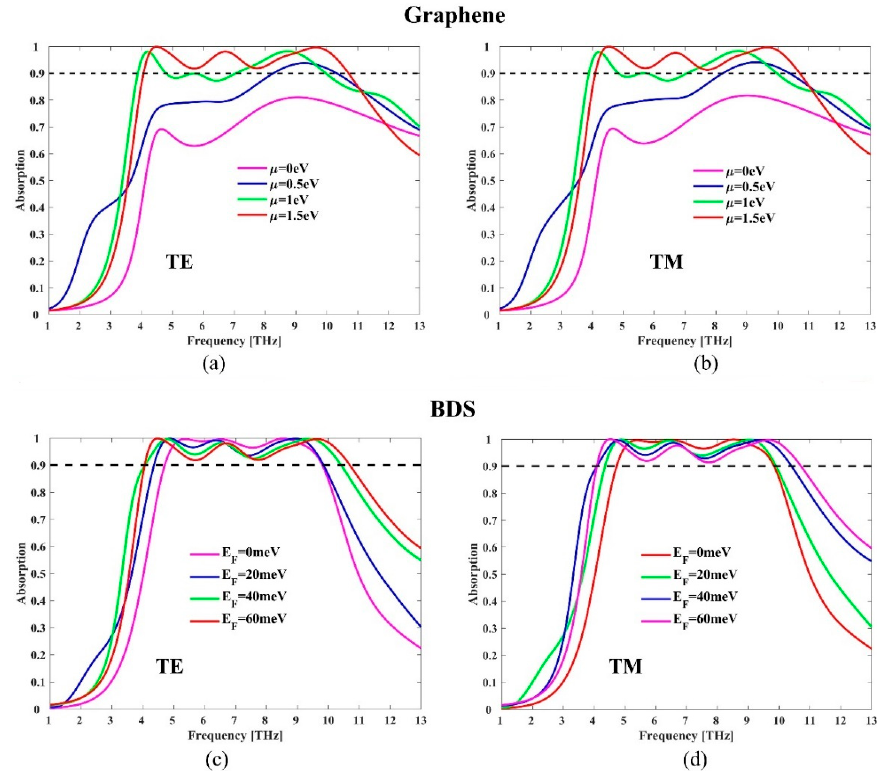
Figure 4. Absorption spectra with di ff erent graphene Fermi energy u = 0 eV, 0.5 eV, 1 eV, and 1.5 eV for ( a ) TE and ( b ) TM polarizations. Absorption spectra with di ff erent BDS Fermi energy E F = 0 meV, 20 meV, 40 meV, and 60 meV for ( c ) TE and ( d ) TM polarizations. BDS o ff ers another possibility to tune the absorption performance of the hybrid